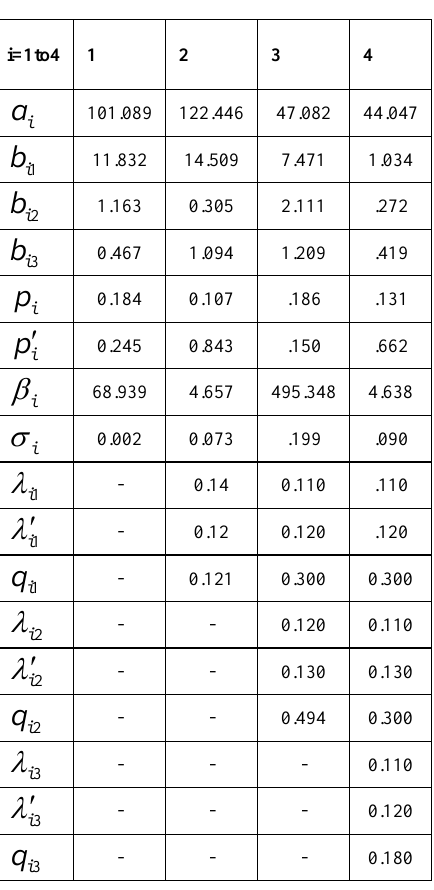
Table 2. Parameter